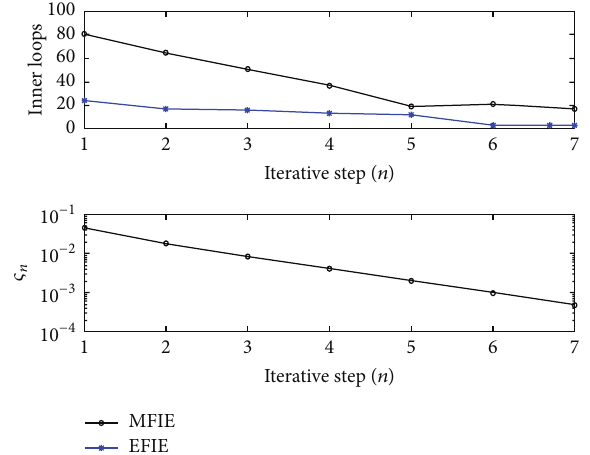
Figure 5: The parameters of rough surface: ℎ = 0.1𝜆, 𝜀 𝑟1 = 2.5 − 𝑖0.18 , DRCS from dielectric rough surface based on 3DMLUV-FIA method and ACA method.